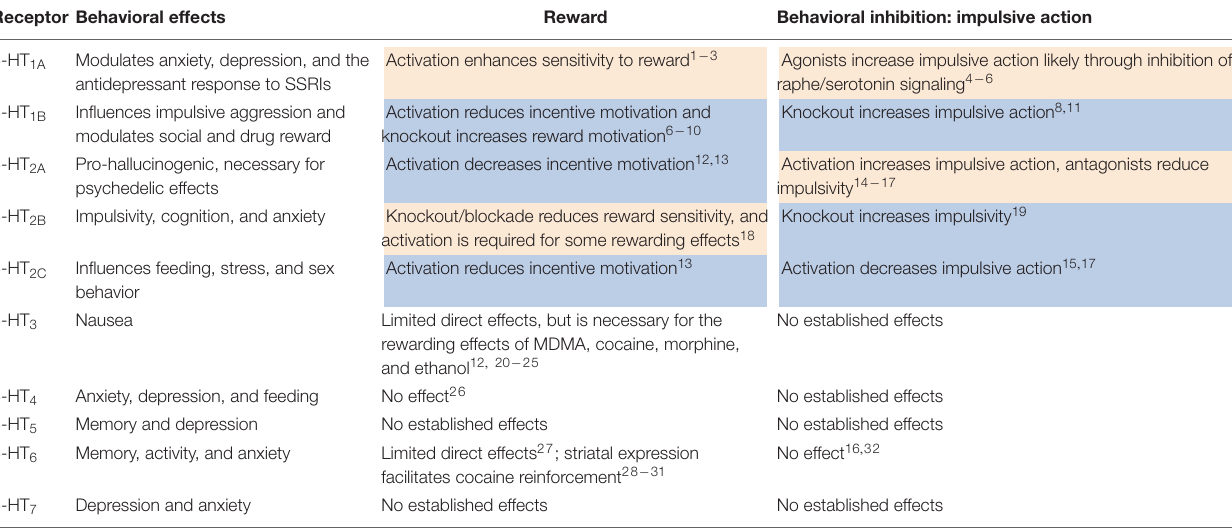
FIGURE 1 | A conceptual schematic of behavioral/cognitive processes that contribute to the control of impulsive action. These are organized into reward “drive” and inhibitory “brake” processes. TABLE 1 | Effects of serotonin receptors on reward-related and impulsive action behavior from preclinical pharmacology and genetic mouse models. Receptor Behavioral effects Reward Behavioral inhibition: impulsive